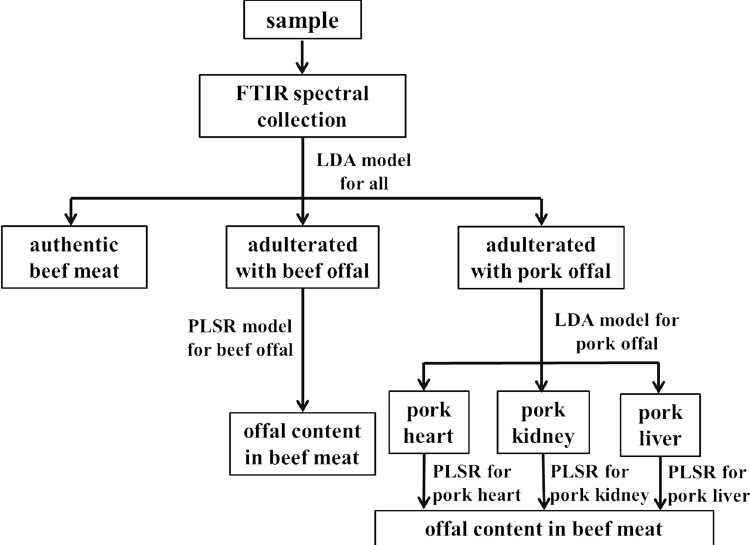
Figure 3. Illustration of the flow chart for the analysis of new ground beef meat